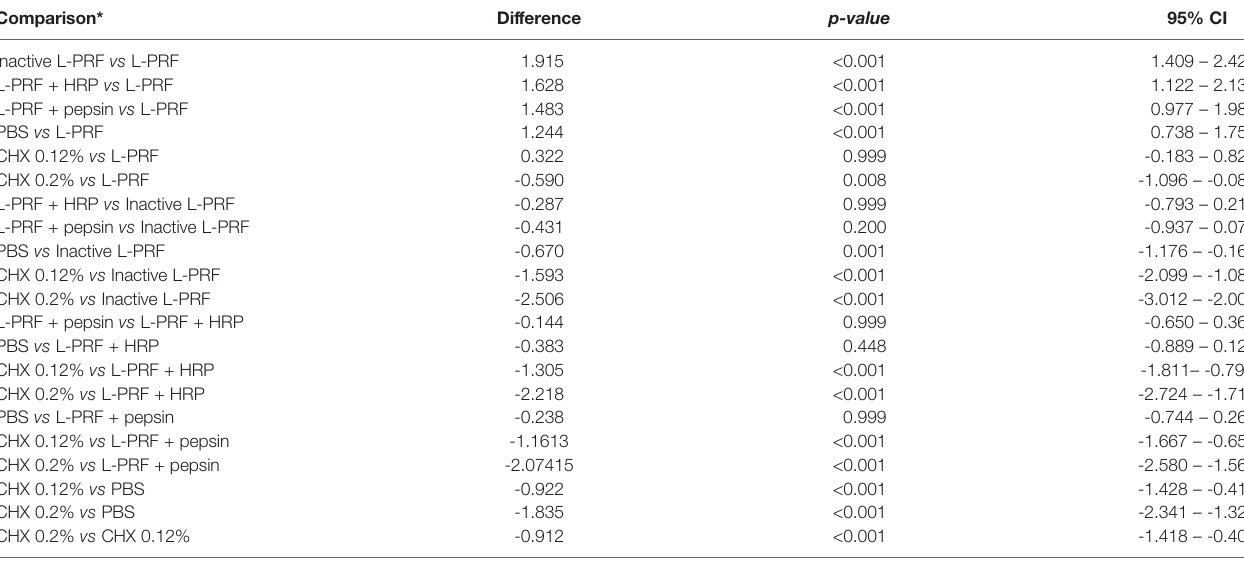
TABLE 2 | Comparisons of the effects of the different solutions on P. gingivalis in planktonic cultures.